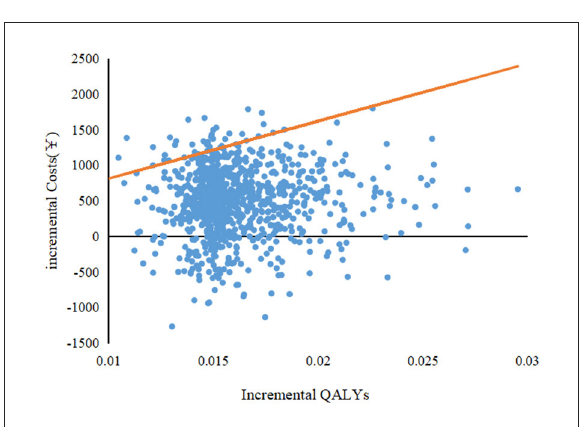
shorter maintenance cycle and costs therefore accrued